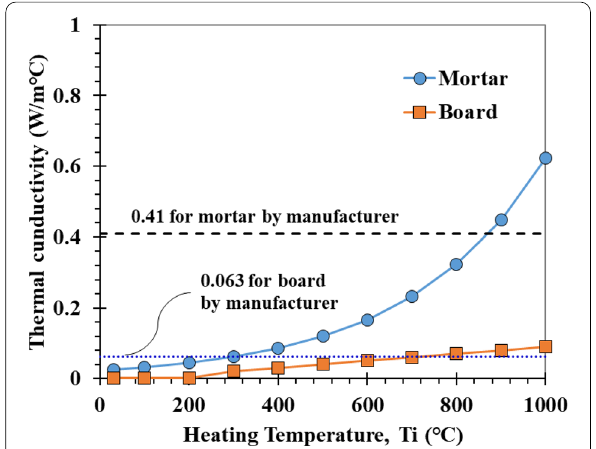
Fig. 27 Assumed thermal conductivity of FP mortar and board from the repeated